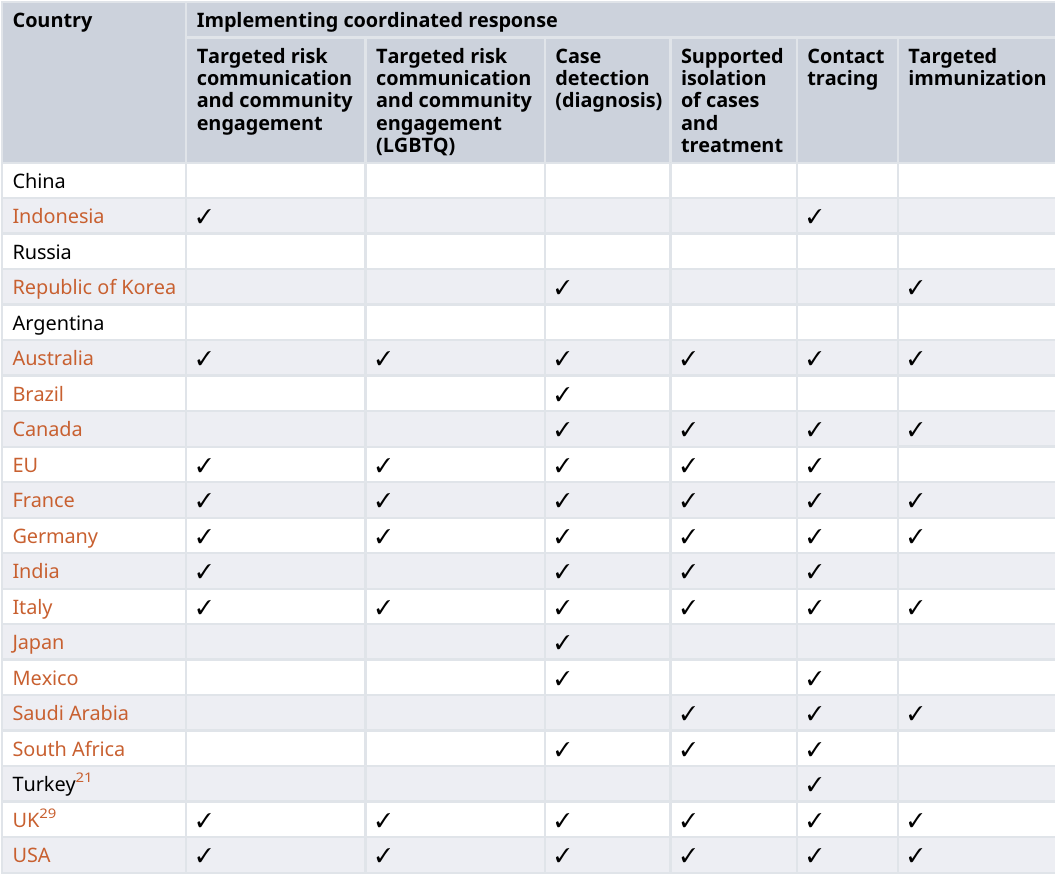
Table 2. Implementing coordinated response. LGBTQ=lesbian, gay, bisexual, transgender, queer, or